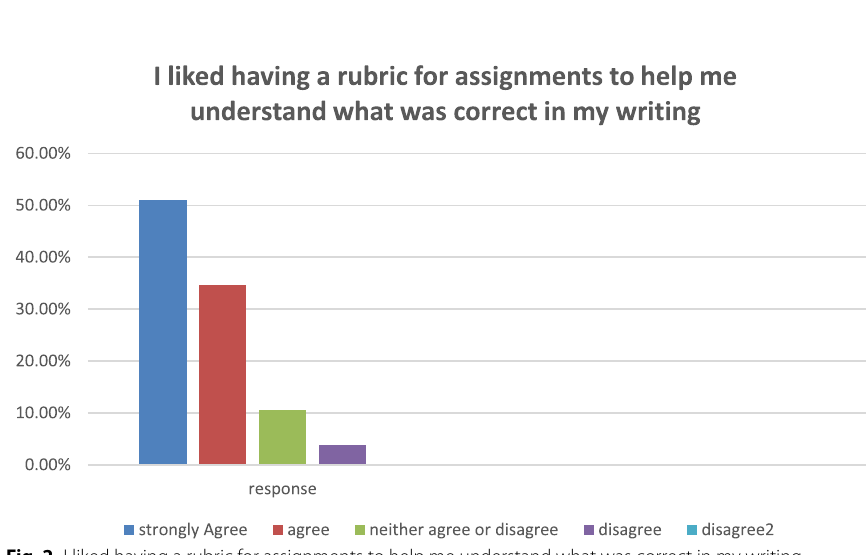
Rubrics helps in understanding what is right in writing